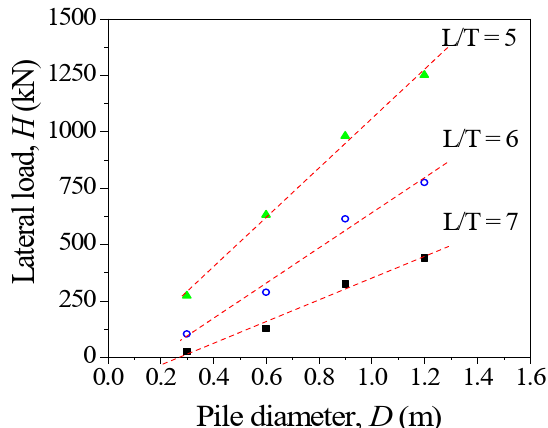
Figure 11. Relationship between lateral load and diameter of CFA piles for various non-dimensional length